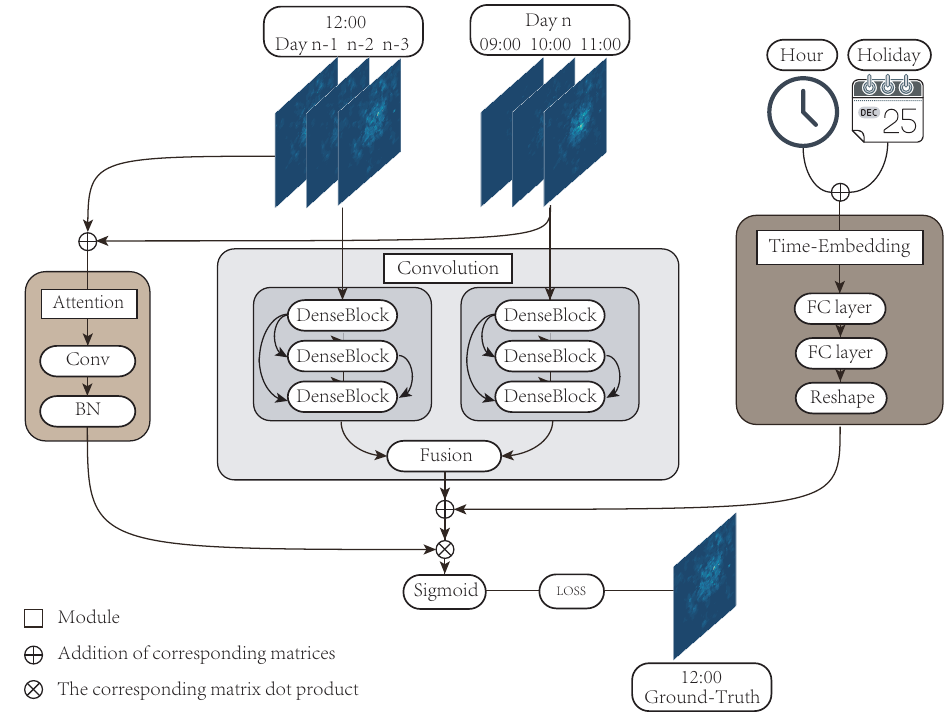
Figure 5. The hybrid spatiotemporal network’s (HSTNet) framework